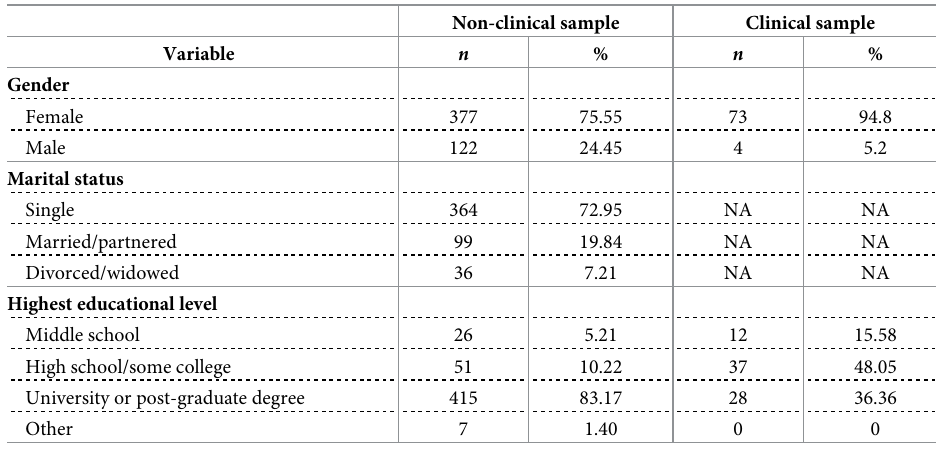
Table 1. Sociodemographic characteristics of